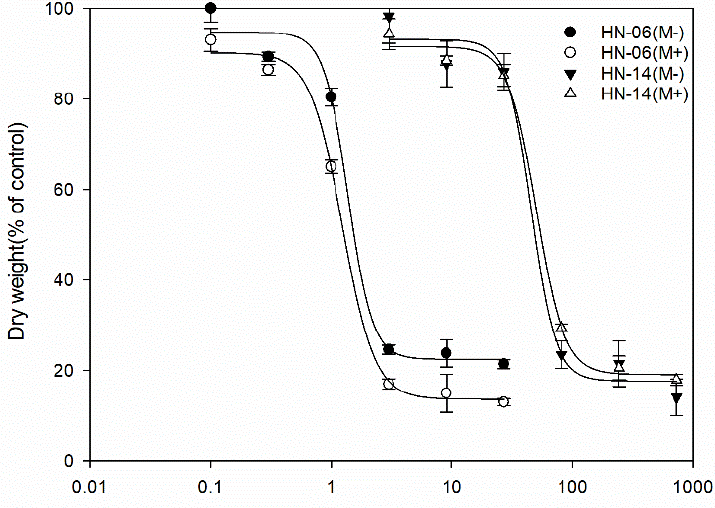
Figure 1. Dose–response curves for dry weight (percent of control) of the resistant (HN-14) and susceptible (HN-06) populations treated with a range of mesosulfuron-methyl doses. M-, absence of malathion pretreatment; M+, presence of malathion at 1000 g ai ha − 1 . Each data point represents the mean percentage survival ± SEM of three replicate treatments. Table 3. GR 50 values of S and R black-grass populations in response to mesosulfuron-methy. Herbicide